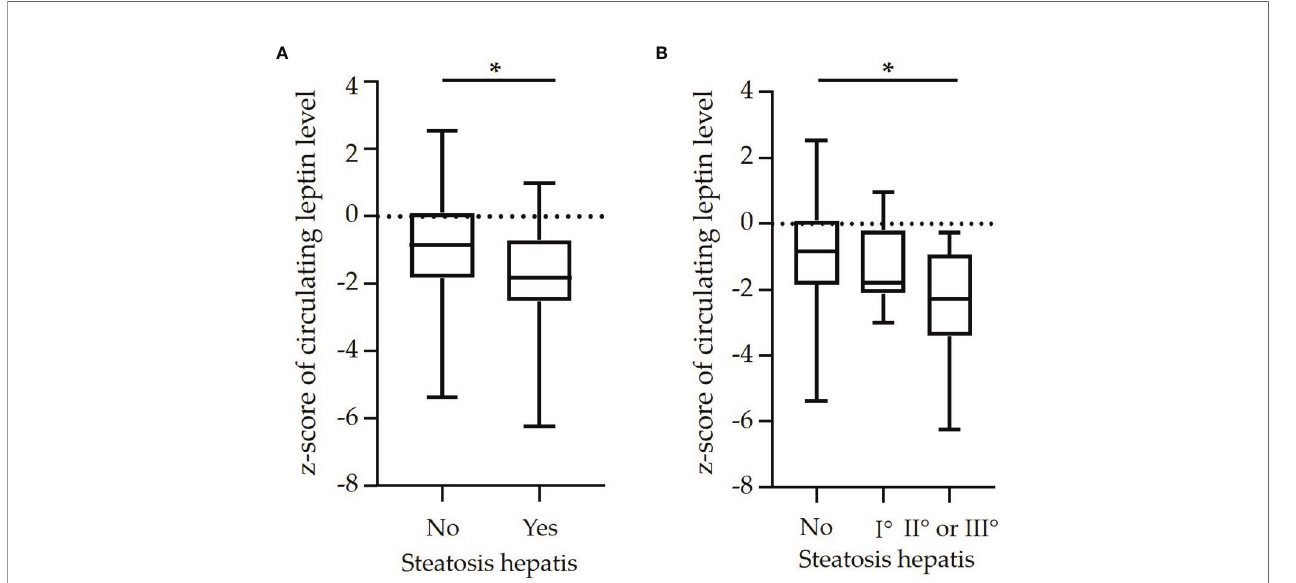
FIGURE 1 | Box plots of z-scores of circulating leptin levels in dependence on (A) diagnosis of steatosis hepatis [yes vs. no (n=64 vs. n=33)] and in dependence on (B) degree of steatosis hepatis [no steatosis hepatis (n=64] vs. mild (I°: n=21) vs. moderate or severe [II° or III°: n=12)] in a cohort of n=97 pre-pubertal children with obesity. (*p<0.05).